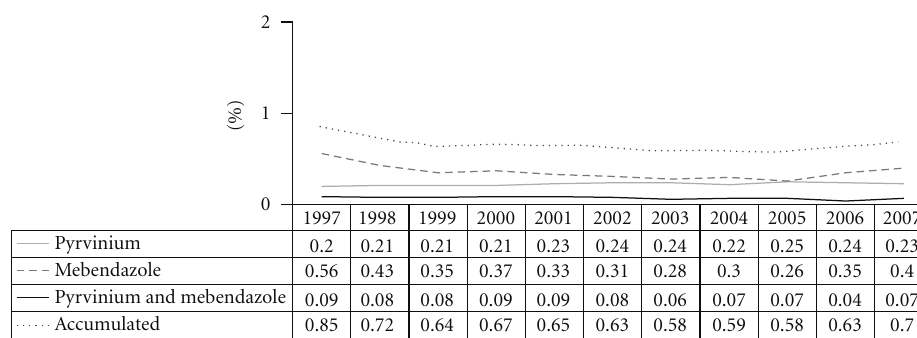
Figure 2: Percentage of pregnancies exposed to pyrvinium, mebendazole, and both drugs for each year in the study period (1997–2007). For each year, data is presented as percentages of all births in the corresponding year.